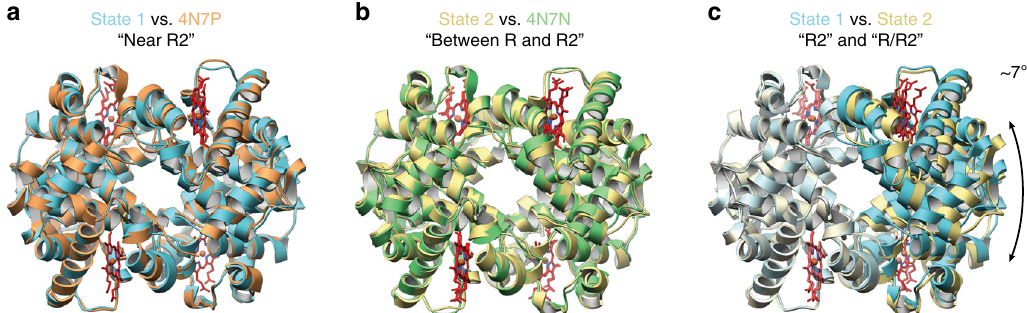
Fig. 3 Multiple conformational states of metHb determined using single-particle cryo-EM. a Cartoon representation of metHb state 1 (~2.8 Å resolution, blue) superposed with PDB ID: 4N7P [10.2210/pdb4N7P/pdb] (chains A – D, orange). b Cartoon representation of metHb state 2 (~3.2 Å resolution, yellow) superposed with PDB ID: 4N7N [10.2210/pdb4N7N/pdb] (chains E-H, green). c Superposing the α 1 and β 1 subunits of states 1 and 2 emphasizes the difference between these two conformations as a ~7° rotation of the α 2 and β 2 (Fig. 2g, h). Furthermore, the well-resolved regions of state 1 contain putative density for ordered water molecules that are conserved between those observed in a previously obtained crystal structure (PDB ID: 2DN1 [https://doi.org/10.2210/pdb2DN1/ pdb]). Our ability to discern subtle conformational differences in a target as small as 64 kDa effectively underscores the utility of this approach in examining the conformational dynamics of similarly small biological systems.